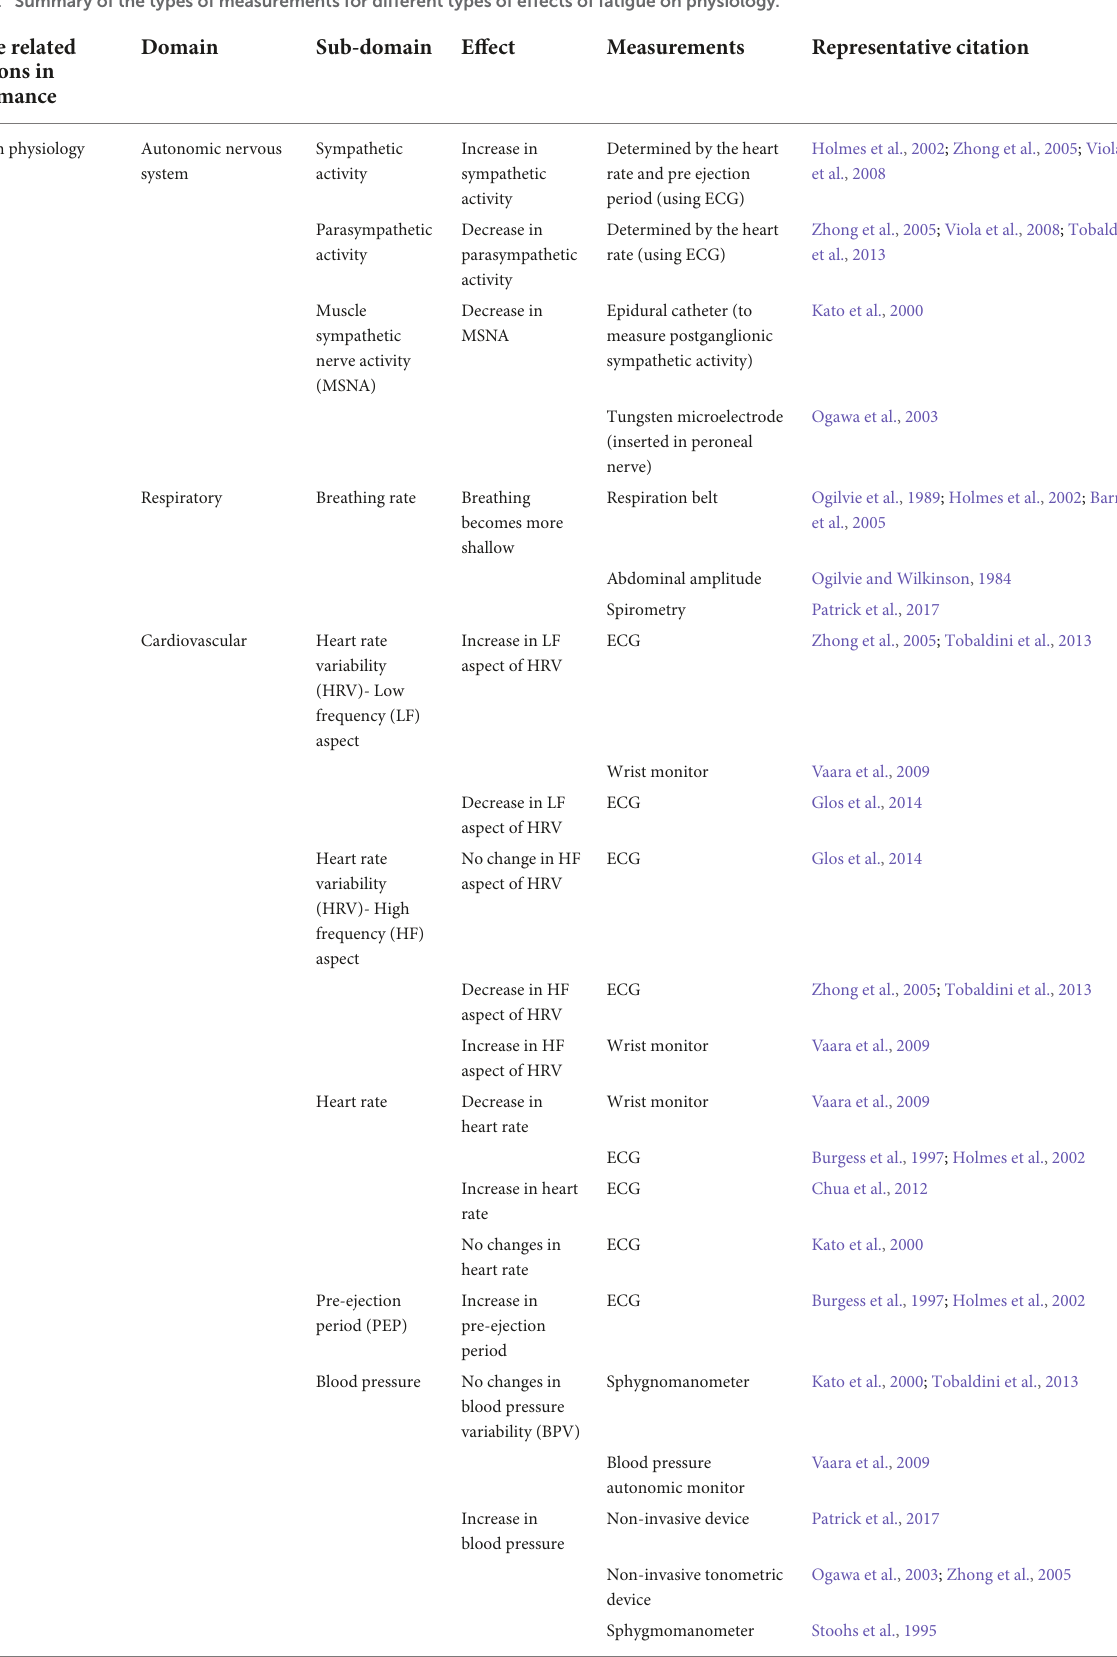
TABLE 2 Summary of the types of measurements for different types of effects of fatigue on physiology. Fatigue related variations